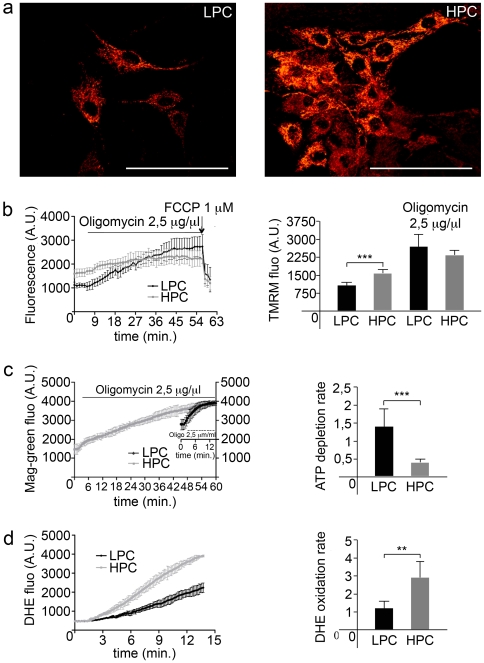
Metabolic characterization of Low and High Proliferative Clones.(a) Confocal images showing TMRM fluorescence as measurement of mitochondrial potential (Δψm). LPC (left) shows, in this culture condition, a lower Δψm compared to HPC (right). (b) Δψm was measured in real time in LPC and HPC using TMRM fluorescence and confocal imaging. Cells were treated with oligomycin (2.5 µg/µl) to block the FO component of the F1FO-ATPasynthase. 1 µM FCCP was added at the end of each experiment to completely depolarize the mitochondria. Diagram on the left shows the trend over time. Values derived from 21 individual cells before and after oligomycin addition for LPC and HPC are summarized in diagram on the right (***p<0.001). (c) Cellular ATP was followed in real time by measuring intracellular [Mg2+]c using the fluorescent dye Magnesium Green (Mag-green). LPC and HPC were treated with oligomycin (2.5 µg/µl) and (left) traces trend monitored over time (traces are mean±s.d. of 10 individual experiments for cell type); plotted values of [Mg2+]c rate (mean±s.d.) is presented in diagram on the right (***p<0.001). (d) ROS production was measured using 5 µg/ml dihydroethidium (DHE). Diagram on the left shows an increase in DHE fluorescence in LPC and HPC recorded in real time and diagram on the right the rate values (mean±SD) of three different experiments are summarized (**p<0.005).